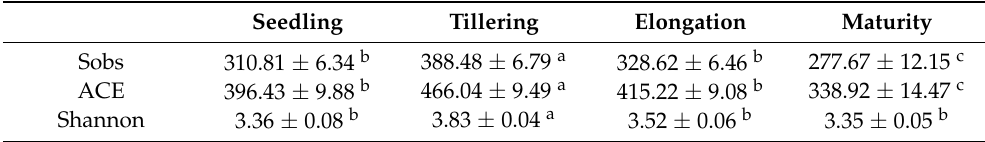
Table 3. Alpha diversity indices for different growth stages.